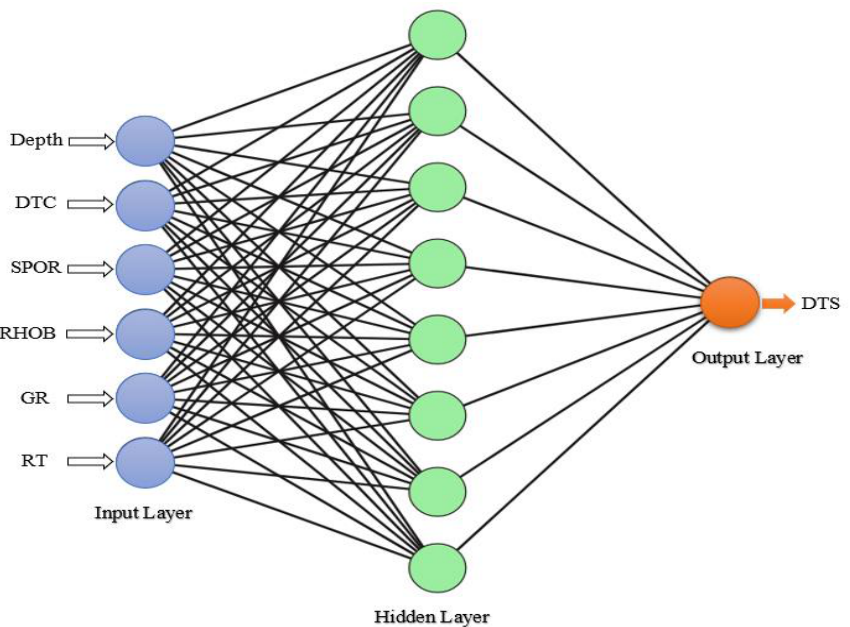
Figure 4. Architecture of Artificial Neural Network.